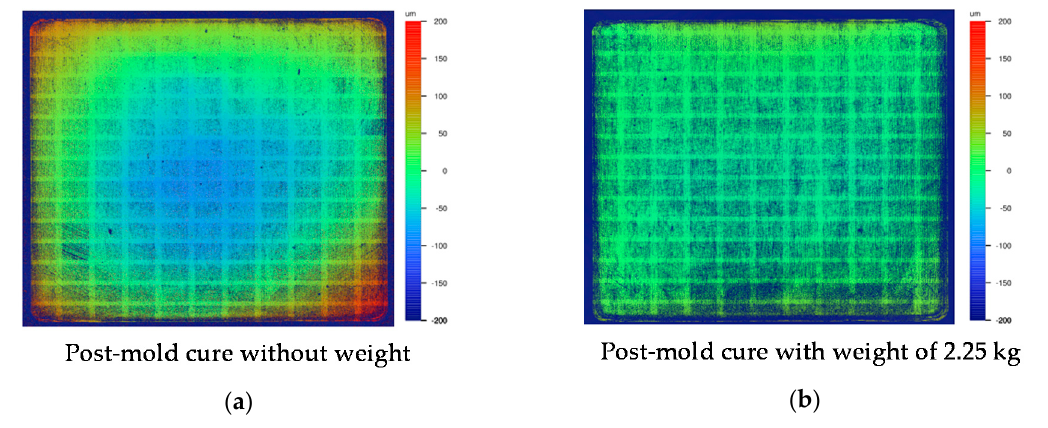
Figure 6. White light interferometry of the cured EMC surface after the post-mold cure of ( a ) test panel 2 without using a weight and ( b ) test panel 5 with using a weight of 2.25 kg. Table 3. Results of the second electrical test after encapsulation by FAM processing of the five test panels. Green stands for a calibrated signal and orange for a signal within tolerance range. Gray marks the channels that were dysfunctional from the beginning, and red shows malfunctioning stacks after encapsulation. The * identifies a change of the signal to the test before. Offset Offset Panel Offset Panel Panel 1 Channel Table 4. Results of the second electrical test after the post-mold cure process of the five test panels. Green stands for a calibrated signal and orange for a signal in a tolerance range. Gray marks the channels that were dysfunctional from the beginning, and red shows malfunctioning stacks after tempering. The * identifies a change and figures in bold type mark an improvement of the signal from the previous test. Offset Panel 1 Offset Panel 2 Offset Panel 3 Offset Panel Channel